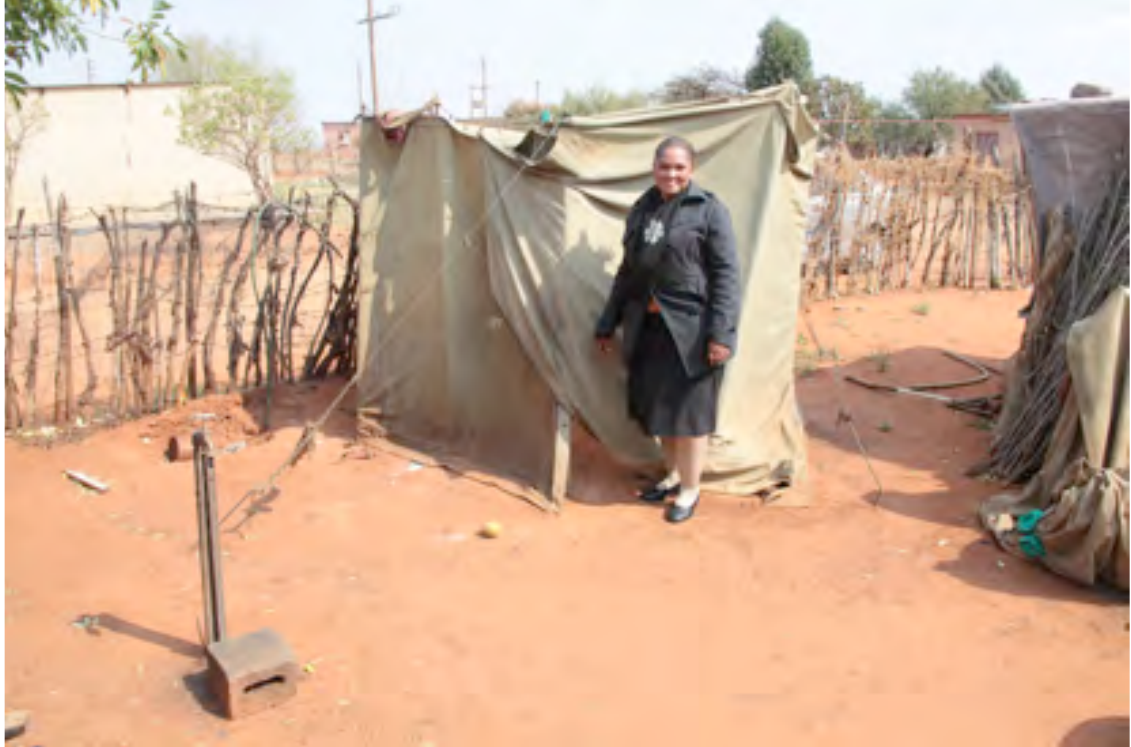
Figure 4 A makeshift cubicle made from the remnants of an old army tent serves as an enclosure for a respected traditional leader and his family to do their ablutions. During interviews local residents complained about the fact that they